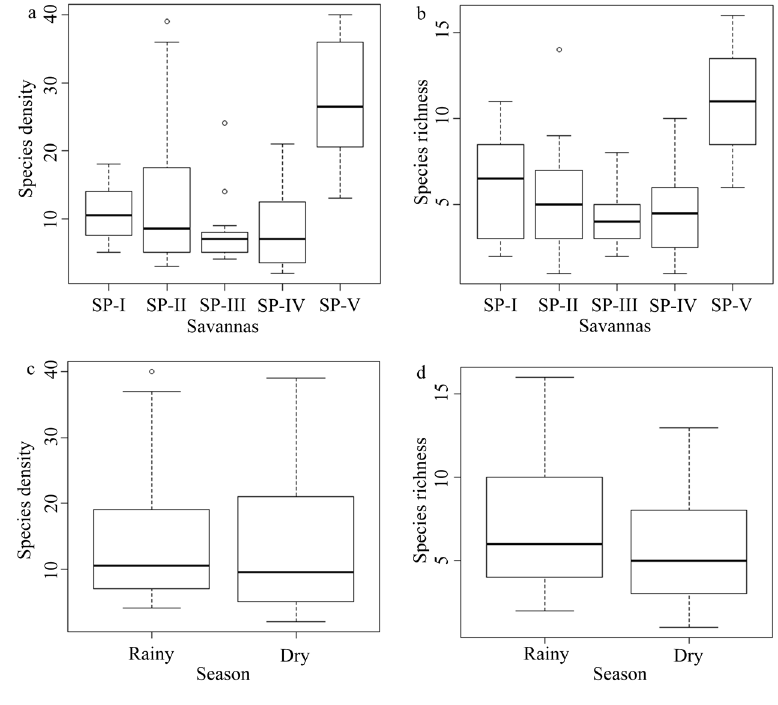
Figure 4. (a) Mean density of bryophytes in the sampled savannas per season; (b) Interaction plot between sampled areas and seasons on mean density of bryophytes; (c) Interaction plot between seasons and sampled areas on mean density of bryophytes.